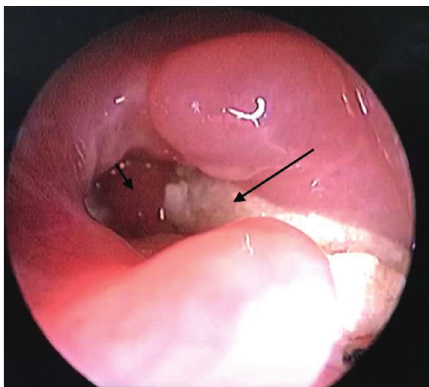
Figure 5: Examination of the pharyngeal entrance and supra- clavicular flap using fiber-optic, after 2 months of surgery. The long arrow indicates supraclavicular flap and the short arrow indicates new pharyngeal lumen input.